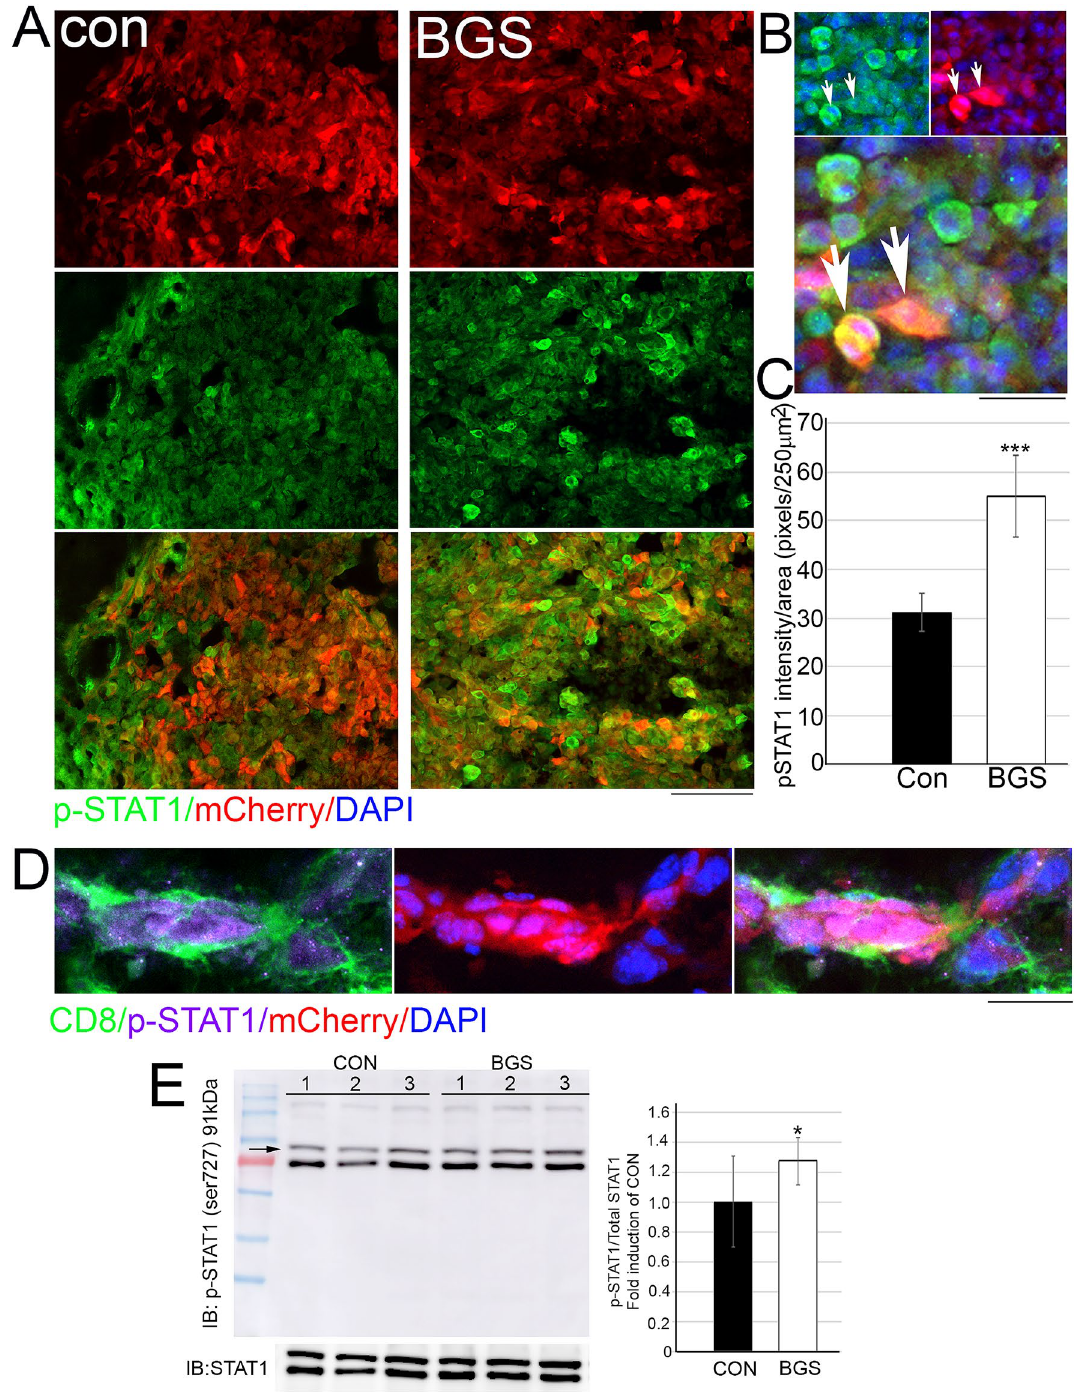
Figure 7. BGS treatment increased p-STAT1 levels in the RET melanoma cells surrounded by CD8 + cells. Seven days after RET cell injection ( A ) Representative images of the control and BGS treatments for p-STAT1 signaling in the tumor cells (mCherry), scale bar 200 µm. ( B ) High power magnification of co-localization of p-STAT1 (green) and mCherry RET melanoma cell (red), scale bar 25 µm. ( C ) p-STAT1 density is significantly increased in the BGS-treated group compared to the control group. Results are presented as mean ± SD (n = 7 animals/ group; ***p < 0.001). ( D ) An example of a CD8 + cell (green) surrounding a mCherry positive RET melanoma cell (red) demonstrated up-regulated p-STAT1 (purple), scale bar 25 µm. ( E ) Tumour lysates from (n = 5 animals/ group) were immunoblotted with p-STAT1 (s727) and total anti-STAT1 antibody in order to determine the fold induction of p-STAT1 levels in BGS treated compared to vehicle-control. Results are presented as mean ± SD (*p <